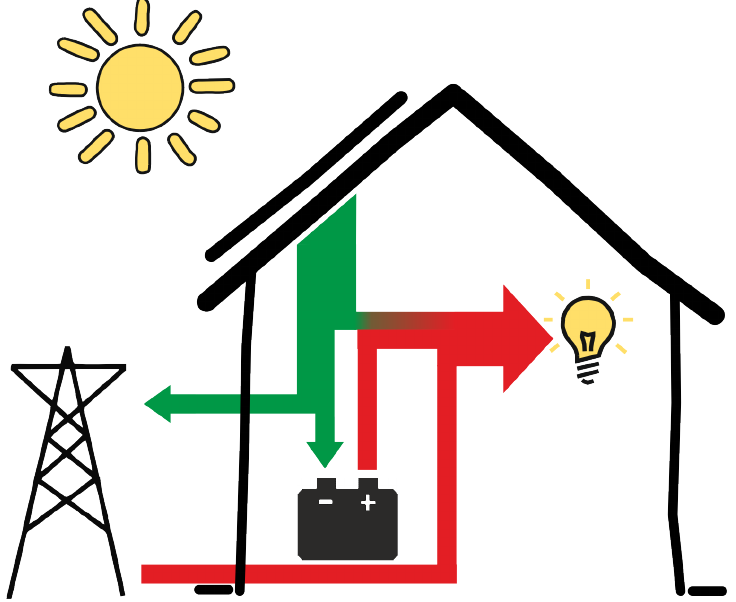
Figure 1. Overview of the energy flows in a domestic smart energy system. The locally-produced energy is shown in green, and the local demand is depicted in